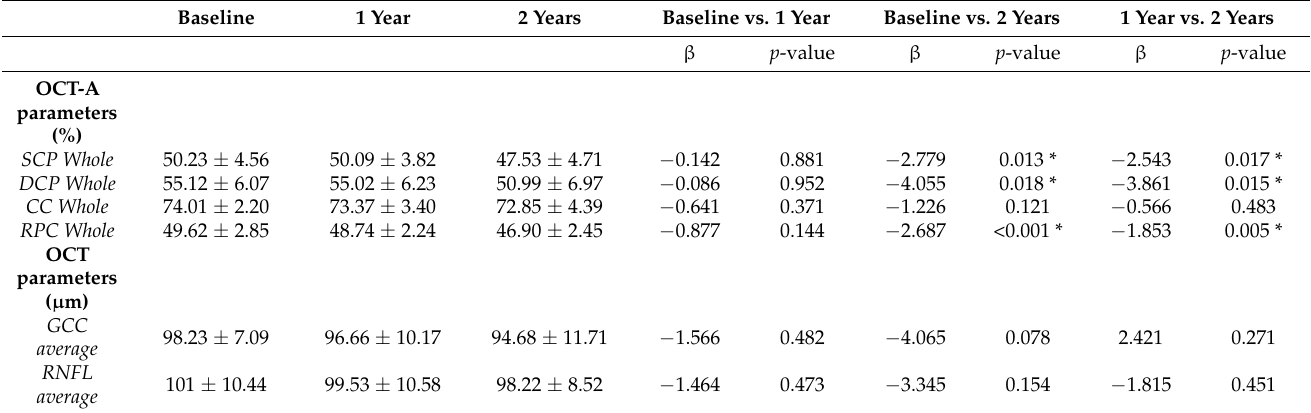
Table 3. Clinical characteristics of patients with IDE at baseline and each time